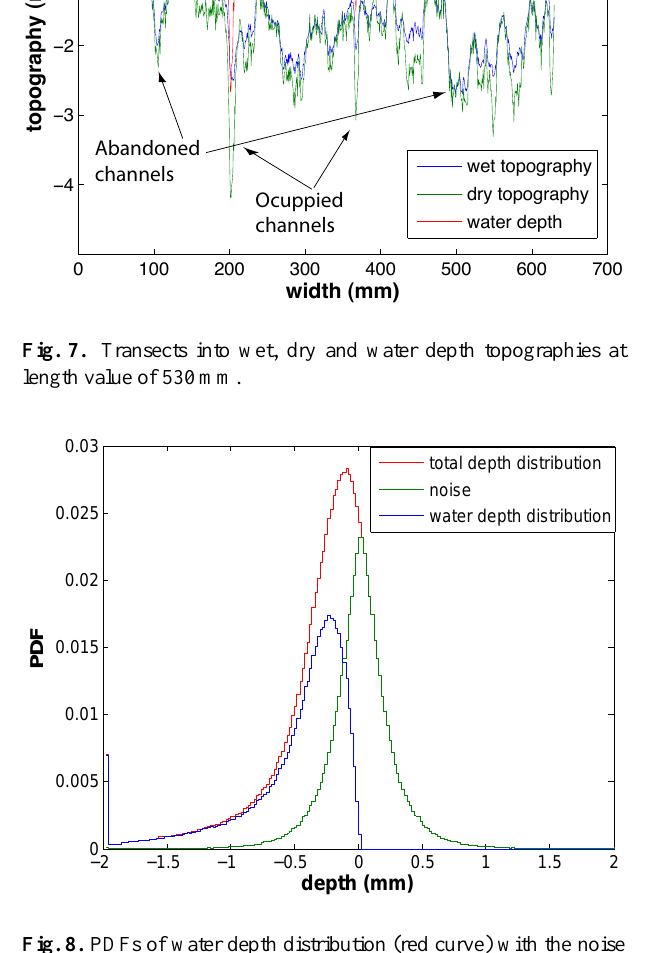
Fig. 8. PDFs of water depth distribution (red curve) with the noise (green curve) removed (blue curve).